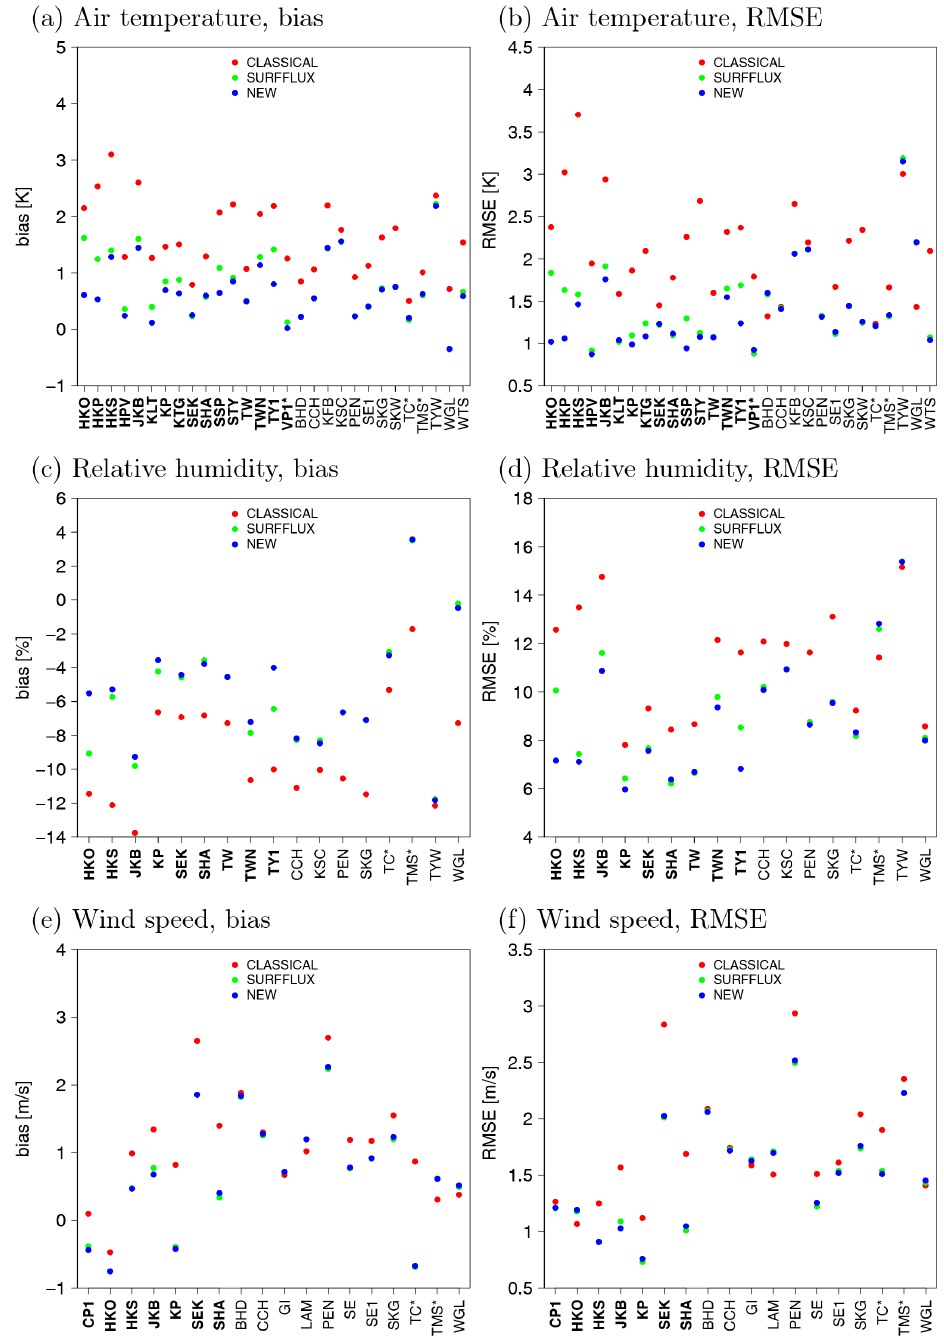
Figure 8. Model evaluation measures for hourly time series at meteorological stations in D4 and for HW2018. The urban stations are bold; the stations on mountain peaks are marked with an asterisk